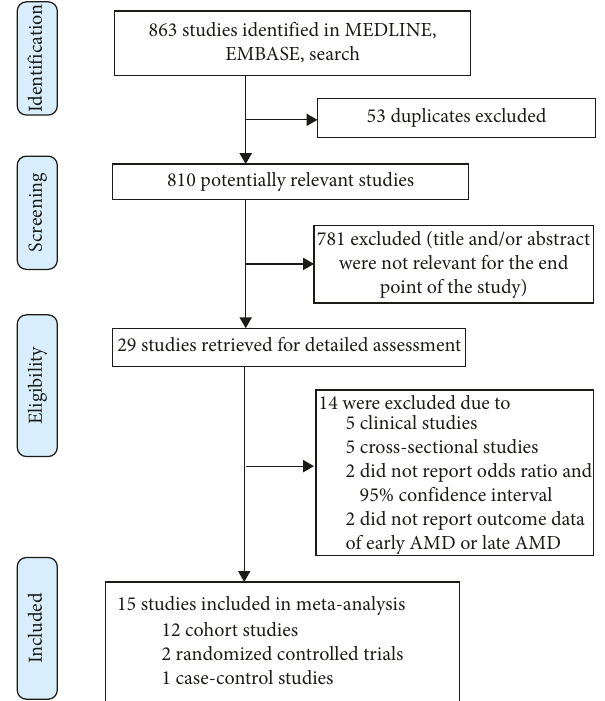
Figure 1: Study selection process. AMD � age-related macular